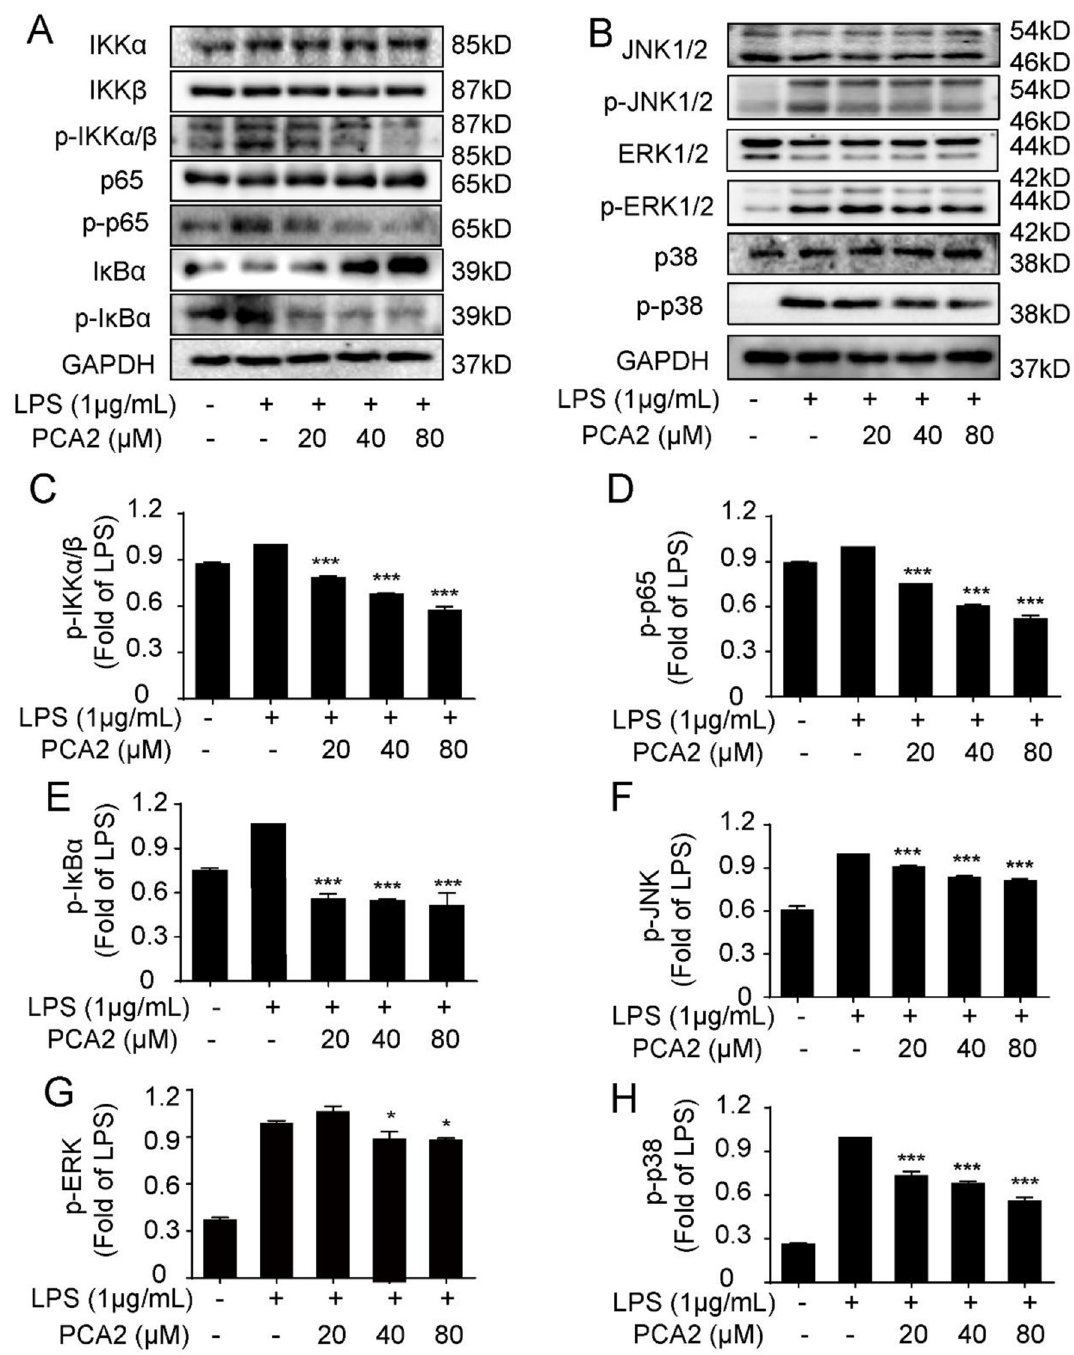
Fig 6. PCA2 ameliorated LPS-induced inflammatory activity through the NF- κ B/MAPK pathways. The cell was exposed to PCA2 (20, 40, 80 μ M) for 1 h and cultured with LPS for 8 h, except for the control group. Protein expression of (A) NF- κ B and (B) MAPK pathway including (C) p-IKK α / β , (D) p-p65, (E) p-I κ B α , (F) p- JNK1/2, (I) p-ERK1/2, and (J) p-p38 was measured by western blotting (n = 3). � p < 0.05, ��� p < vs. LPS group 0.01.